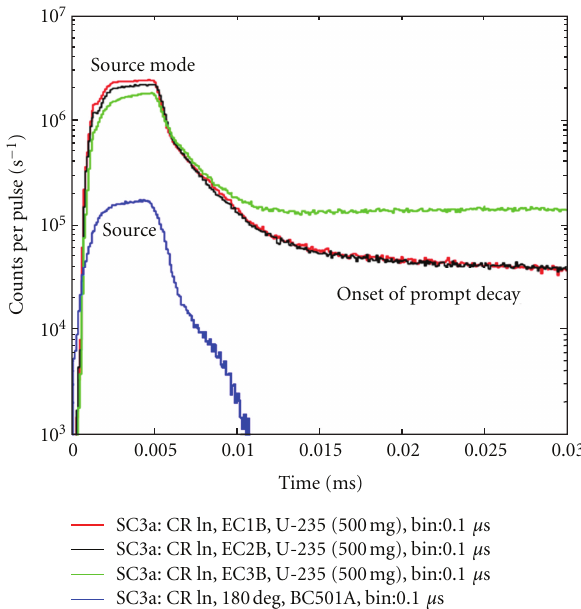
Figure 5: Detector responses in the pulsed neutron source experi- ment at three di ff erent detector positions in the fast area of the SC3A configuration of YALINA-Booster